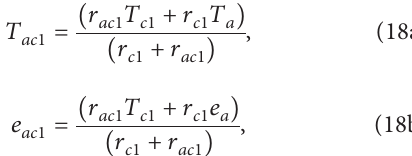
g s max in the s and